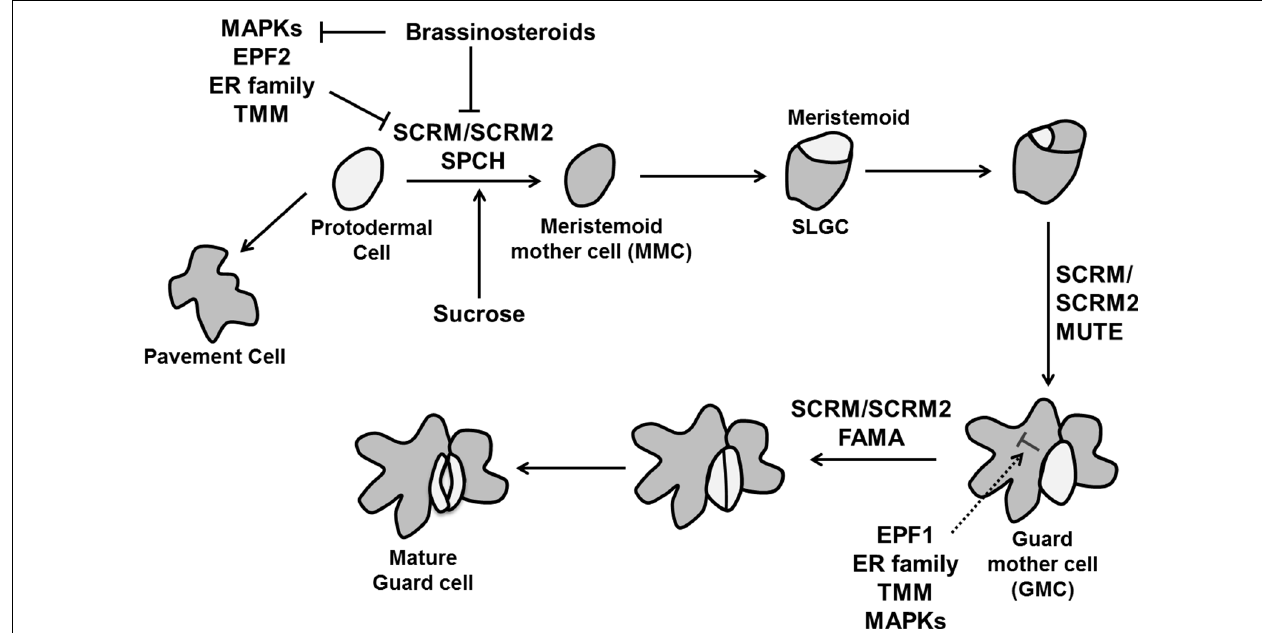
FIGURE 10 |The control of stomatal development. Stomatal fate is determined by three transcription factors, SPEECHLESS (SPCH), MUTE, and FAMA. Specification of stomatal lineage where conversion of a protodermal cell into a meristemoid mother cell (MMC) is regulated by SPCH, MUTE controls the transition from meristemoid to guard mother cell (GMC) and FAMA is essential to make functional guard cells from GMC.The MAPK